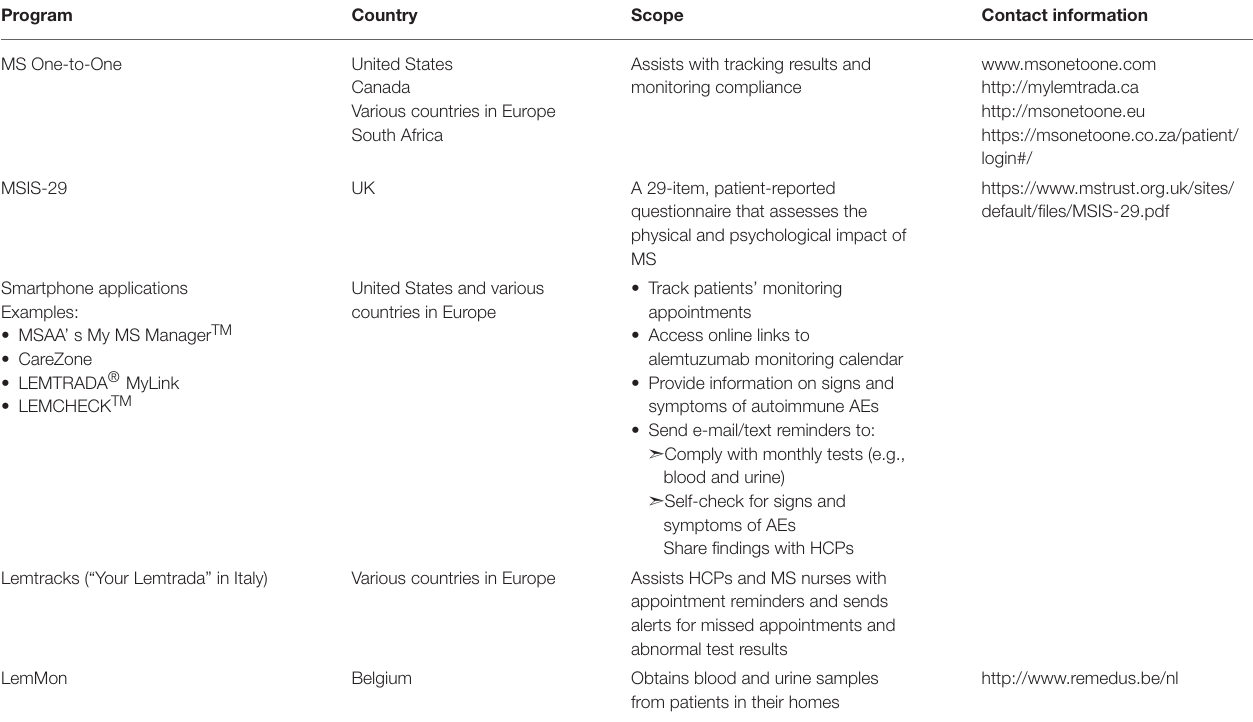
TABLE 2 | Patient support tools for monitoring and follow-up after treatment with